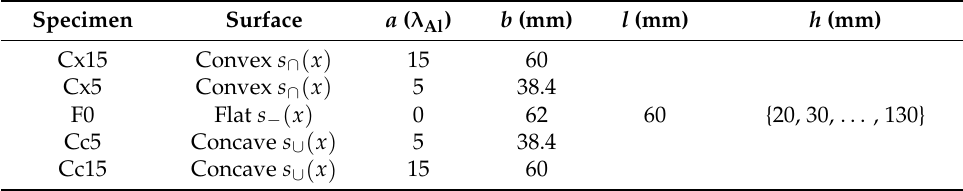
Table 1. Specimen surface curvature parameters and probe standoffs.